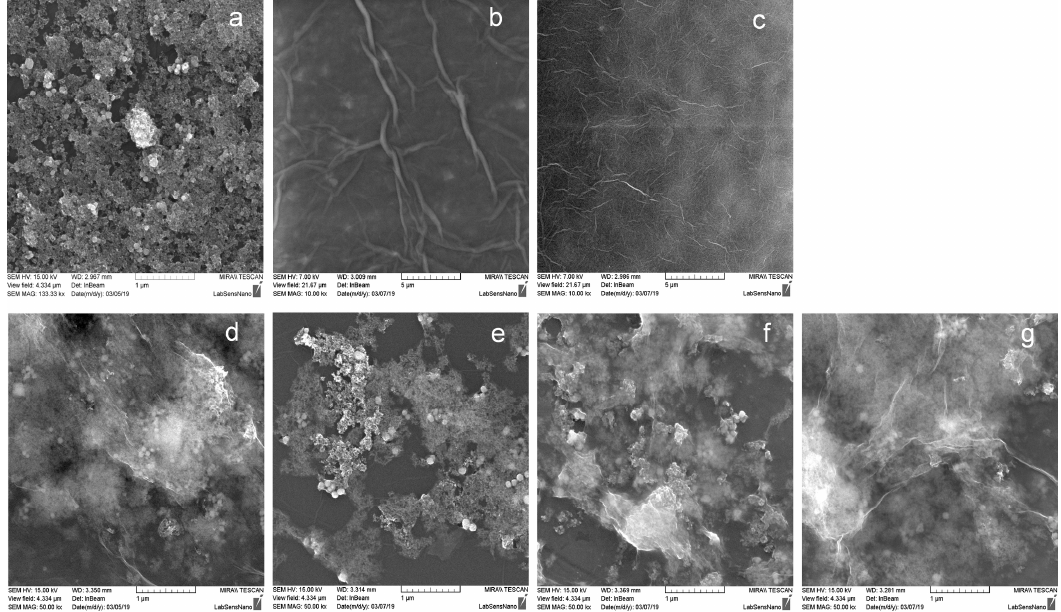
Figure 3. Scanning electron microscopy (SEM) characterization of materials: ( a ) Structure of microparticles (MPs); ( b ) structure of large area graphene oxide (GOH) with bigger wrinkles; ( c ) structure of small area graphene oxide (GOJ) with little and finer wrinkles; ( d ) GOH layered structure wrapping MPs; ( e ) GOJ layered structure wrapping MPs; and ( f ) large area graphene oxide modified by iron oxide based microparticles (MGOH) composite after the regeneration process; MGOH composite with Se(IV) bound ( g ).